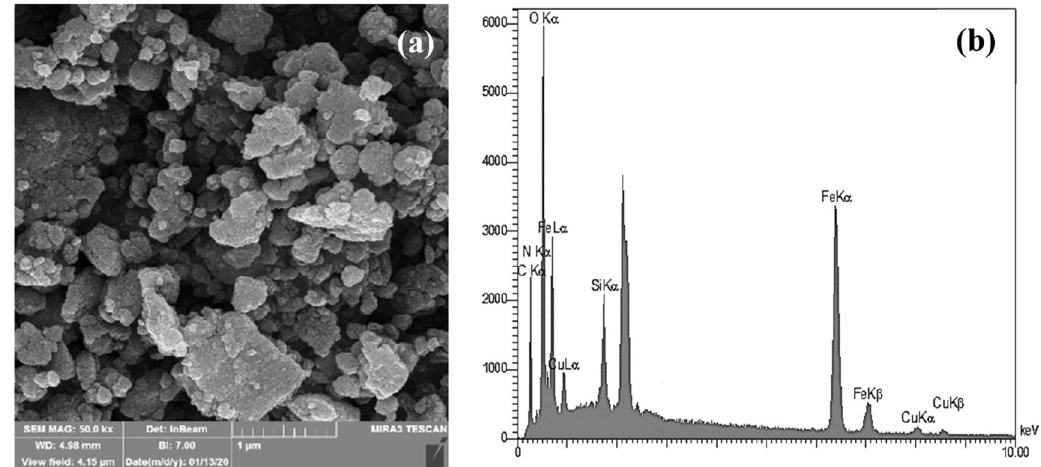
Figure 5. The FESEM image ( a ) and EDX ( b ) of Fe 3 O 4 @Pectin@(CH 2 ) 3